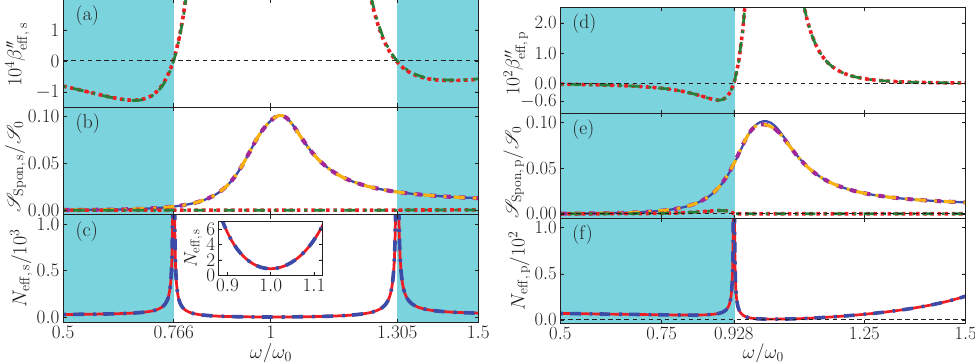
Figure 3. The power spectrum (A20) of the spontaneous emission of noise photons exiting a loss- compensated multilayer metamaterial at an angle of 30 degrees away from the normal, in units of S 0 = ¯ h ω 3 /4 πε 0 c 3 , due to spontaneous emission of noise photons within the loss-compensated 0 multilayer metamaterial is sketched in Figure 6, at zero temperature. Left and right panels correspond to s - and p -polarized light, respectively. The amplifying and absorbing layers are described by the Lorentz model (Equation (40)), with parameters ω p / ω 0 = 0.3, γ a / ω 0 = 0.1 for the lossy layers, a and ω p / ω 0 = 0.25, γ b / ω 0 = 0.15 for the layers with gain. We choose d a,b ω 0 / c = 0.1 and five b unit cells. The parts ( a , d ) show the imaginary part of the normal wave-vector component β eff . In panels ( b , e ), the power spectrum of the noise photons predicted with the effective-index theories is compared to the exact multilayer calculation and the QOEM theory. For the effective-index theories, red dotted curves are obtained by inserting effective parameters based on Equation (A15a) into Equation (A20); the green dash-dotted lines correspond to the other procedure Equation (A17) to obtain effective parameters. Similarly, for QOEM theory (discussed in Section 5), the magenta dashed lines are produced with Equation (A15a), and the yellow dash-dotted curves with Equation (A17). Panels ( c , f ) show the effective noise current densities N eff of Equation (35), in solid red lines as obtained using the effective index of Equation (A15a) and in dash-dotted blue curves as produced with the other procedure (Equation (A17)) to obtain the effective index.